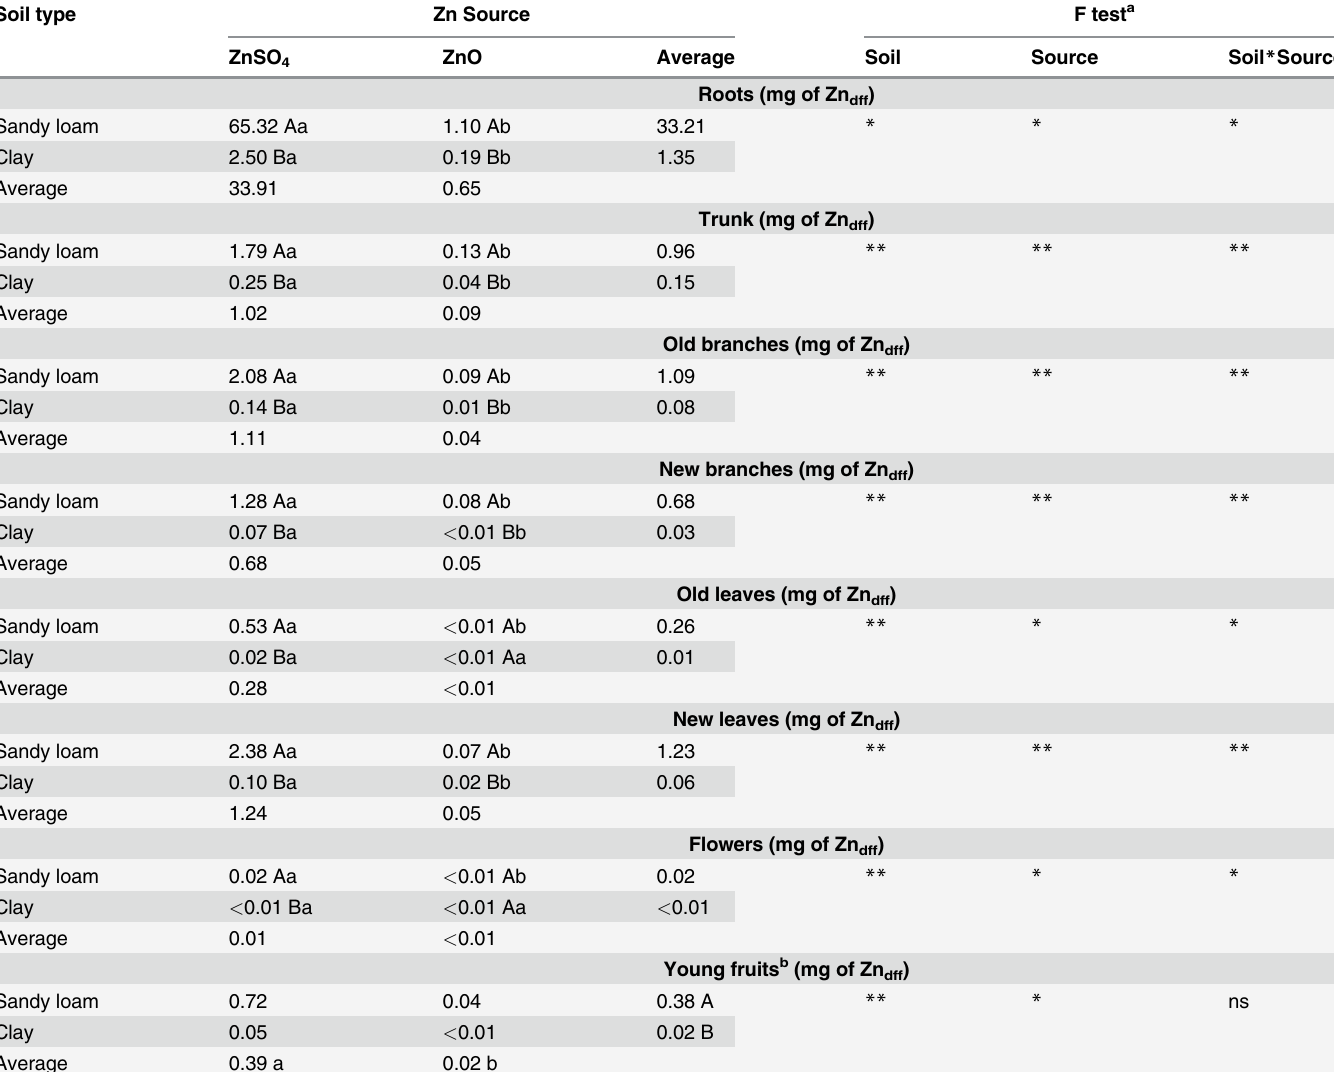
Table 5. Zinc derived from fertilizer (Zn dff ) in young orange trees 150 days after 68 Zn application in soils with sandy loam or clay